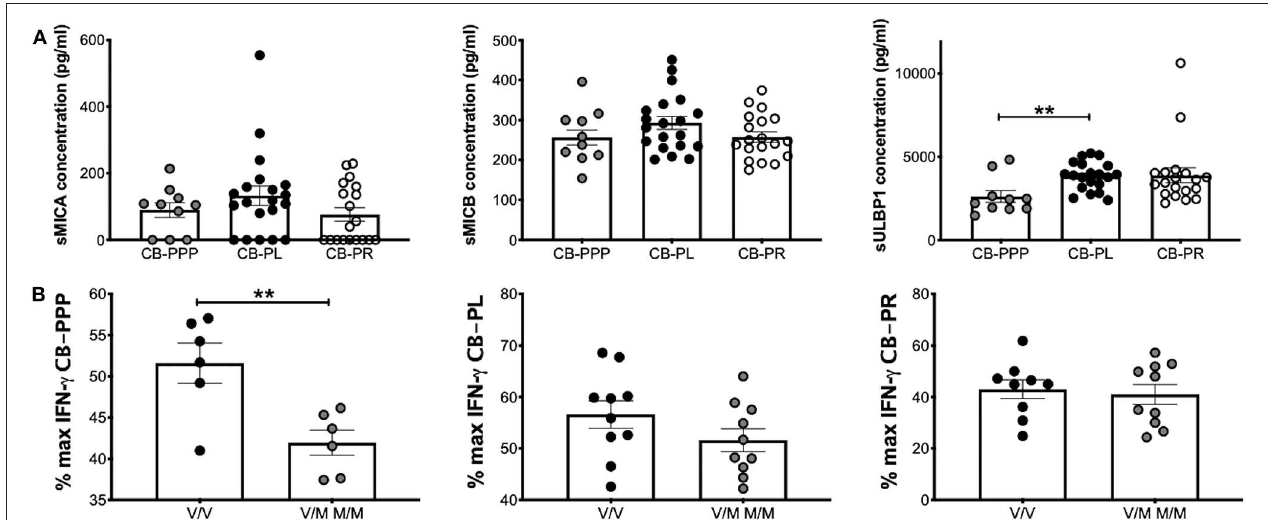
FIGURE 7 | CB-PRP preparations (CB-PPP, CB-PL, and CB-PR) contain immunosuppressive soluble NKG2D ligands. (A) ELISA analysis of soluble NKG2D ligand content (sMICA, sMICB, and sULBP1) in CB-PPP ( n = 10), CB-PL ( n = 20), and CB-PR ( n = 19) revealed similar quantities of sMICA and sMICB. Significantly higher concentration of sULBP1 was found in CB-PL compared with CB-PPP. (B) MICA genotyping was performed with DNA obtained from whole CB used to prepare CB-PL ( n = 20), CB-PR ( n = 19), and CB-PPP ( n = 12). MICA-129 valine homozygotes (V/V) were compared with heterozygote and homozygote MICA-129 methionine genotypes (V/M or M/M) for each preparation. Statistical analysis was performed using non-parametric one-way ANOVA (Kruskal-Wallis test with Dunn’s post-hoc test) or Mann Whitney test. ** p <